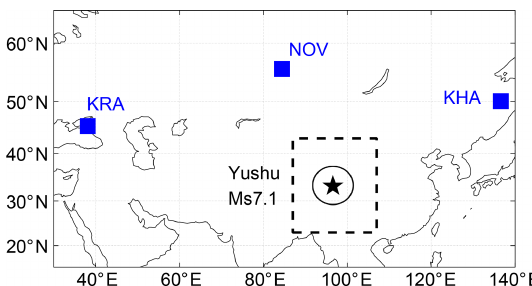
Figure 1. The locations of transmitters and the Yushu earthquake. The blue squares represent the locations of the three transmitters (KRA, NOV, and KHA) in Russia. The epicenter of Yushu earth- quake is denoted by the black star. The black square covers the re- gion of the epicenter ± 10 ◦ , in which the data have been